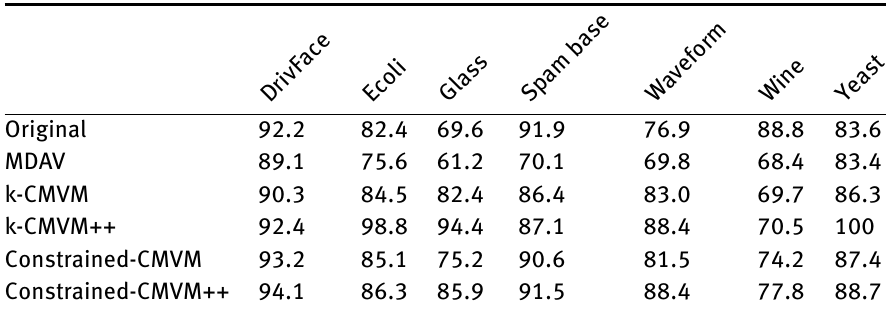
Table 2: Comparison of the separability utility of the base method MDAV, k-CMVM, Constrained CMVM before and after intro- ducing the discriminant